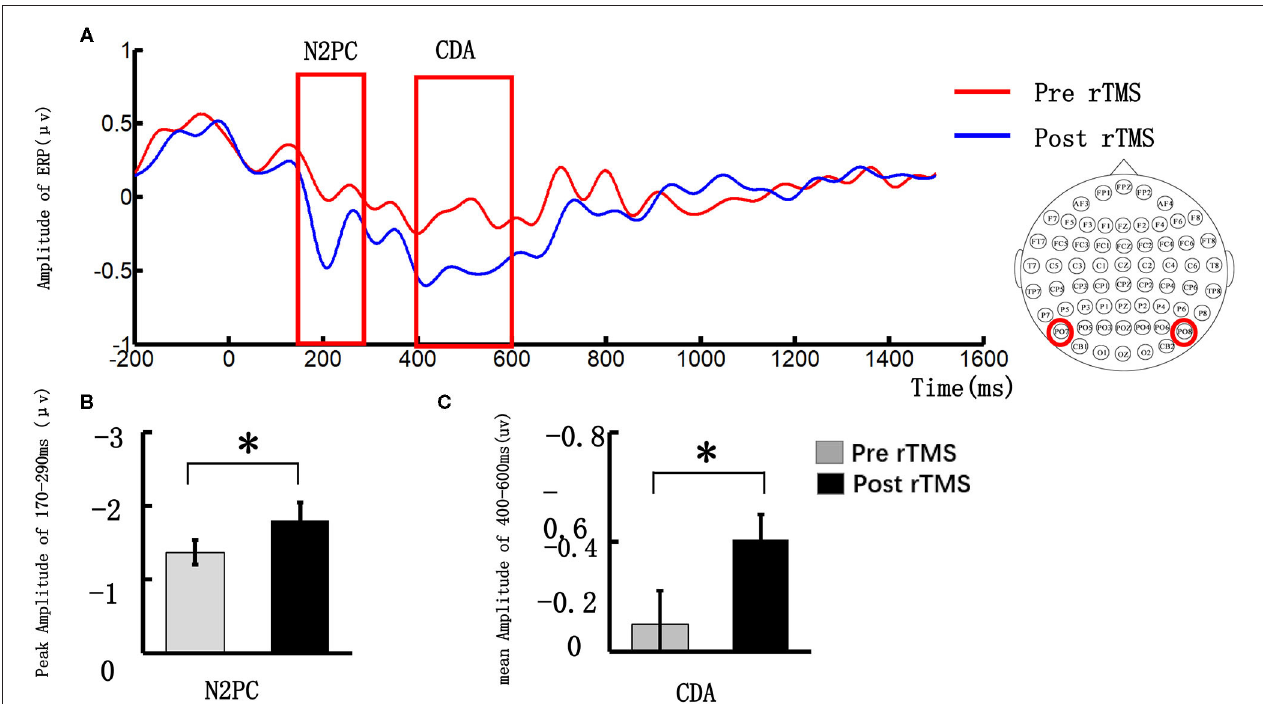
FIGURE 3 | Grand average event-related potentials and amplitude differences of the N2PC and CDA pre- and post-stimulus repeated transcranial magnetic stimulation (rTMS). (A) illustrates the event-related potential (ERP) amplitude in the visual memory trial; the N2PC time window (170–290ms) and CDA time window (400–600ms) were highlighted in the red strip; (B) demonstrates the N2PC amplitude difference during the VWM task between the pre- and post-stimulus periods; (C) demonstrates the CDA amplitude difference during the VWM task between the pre- and post-stimulus periods. * p <